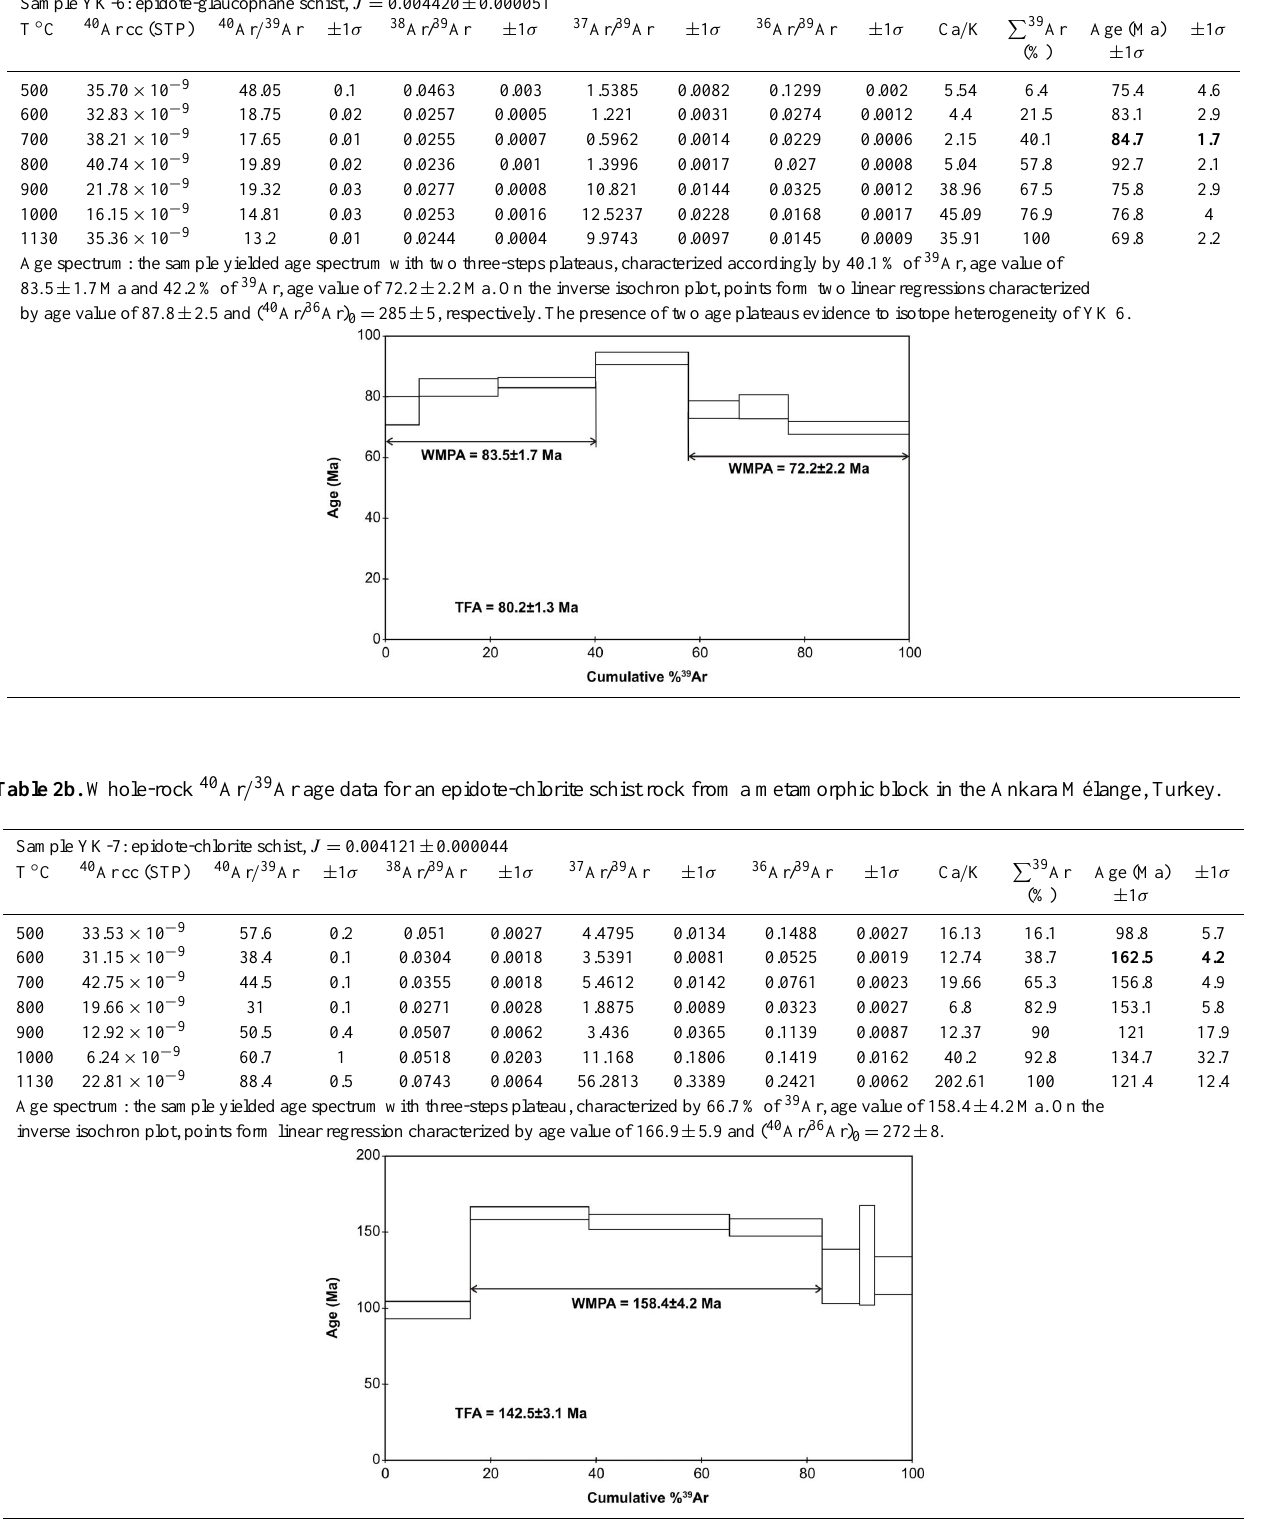
Table 2a. Whole-rock 40 Ar / 39 Ar age data for an epidote-glaucophane schist rock from a metamorphic block in the Ankara Mélange, Turkey. Sample YK-6: epidote-glaucophane schist, J = 0 . 004420 ± 0 . 000051 T ◦ C 40 Arcc (STP) 40 Ar/ 39 Ar